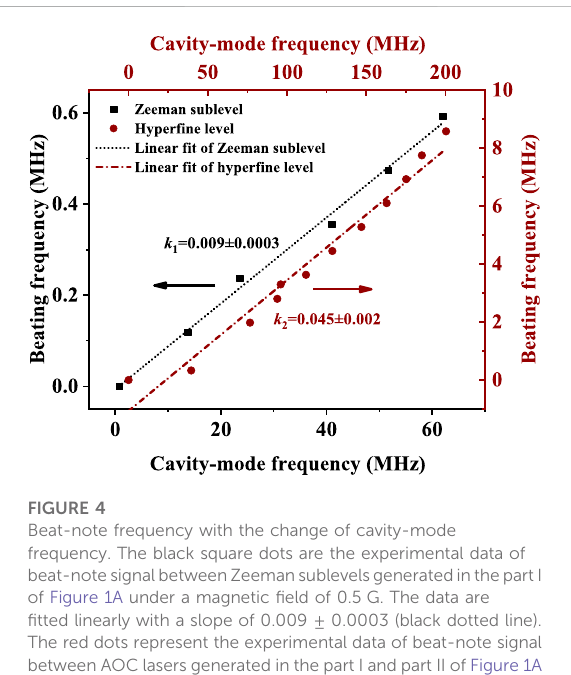
FIGURE 4 Beat-note frequency with the change of cavity-mode frequency. The black square dots are the experimental data of beat-notesignalbetweenZeemansublevelsgeneratedinthepartI of Figure 1A under a magnetic fi eld of 0.5 G. The data are fi tted linearly with a slope of 0.009 ± 0.0003 (black dotted line). The red dots represent the experimental data of beat-note signal between AOC lasers generated in the part I and part II of Figure 1A without an applied magnetic fi eld. Its linear fi tting result is indicated by the red dotted line with a slope of 0.045 ± 0.002.